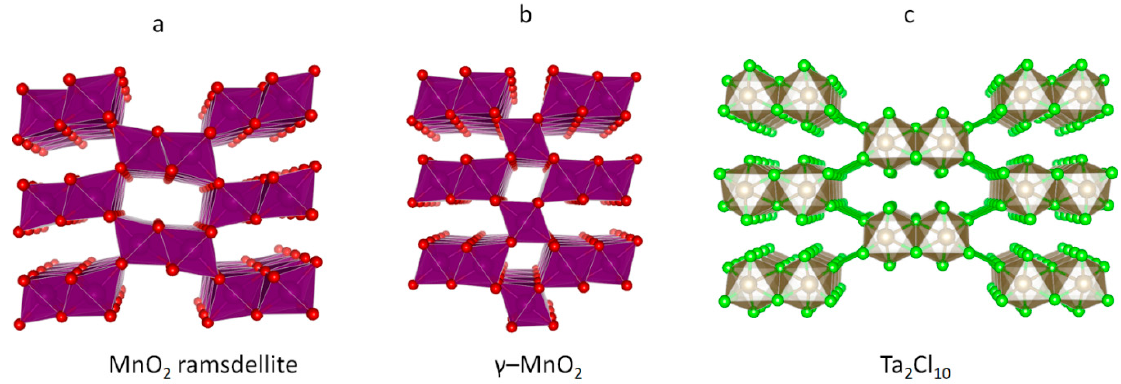
Figure 2. Crystal structure of ( a ) ramsdellite, ( b ) γ -MnO 2 polymorph, and ( c ) that of molecular Ta 2 Cl 10 crystal. In case of the MnO 2 forms, the three-dimensional network of MnO 6 octahedra is highlighted. In case of the molecular Ta 2 Cl 10 crystal, selected van der Waals Cl ... Cl contacts between the isolated edge-sharing MnO 6 octahedra are shown to highlight its relation to the ramsdellite structure.